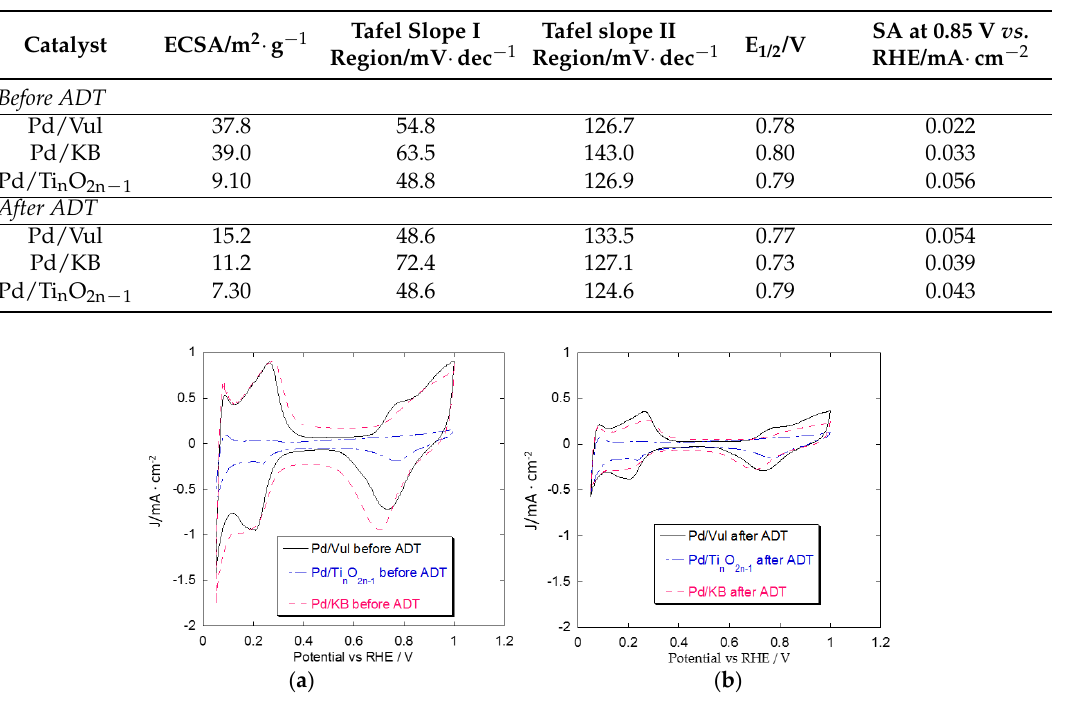
Figure 6. ( a ) CV of 30% Pd/Vul, 30% Pd/KB, 30% Pd/Ti n O 2 n –1 before ADT; ( b ) CV of 30% Pd/Vul, 30% Pd/KB, 30% Pd/Ti n O 2 n –1 after 1000 potential cycles. 30% Pd/KB, 30% Pd/Ti n O 2 n ´ 1 after 1000 potential